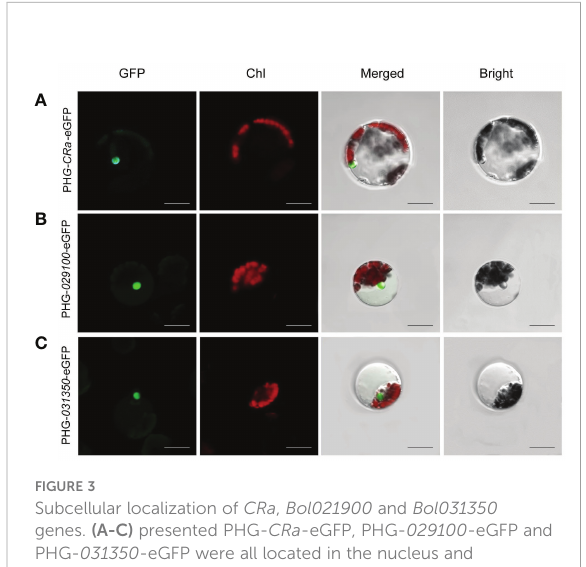
FIGURE 3 Subcellular localization of CRa , Bol021900 and Bol031350 genes. (A-C) presented PHG- CRa -eGFP, PHG- 029100 -eGFP and PHG- 031350 -eGFP were all located in the nucleus and transiently co-expressed in broccoli B1 protoplasts; Individual and merged images of GFP and chlorophyll auto fl uorescence (Chl) as well as bright fi eld images of protoplasts were shown. Scale bars = 10 m